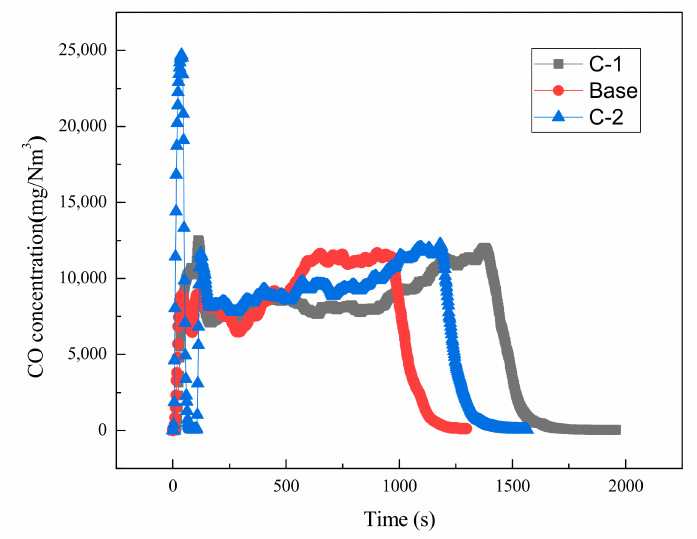
Figure 8. CO emission concentration during sintering at various ratios of water. (Water ratios: C-1 = 7; Base = 7.5; C-2 =